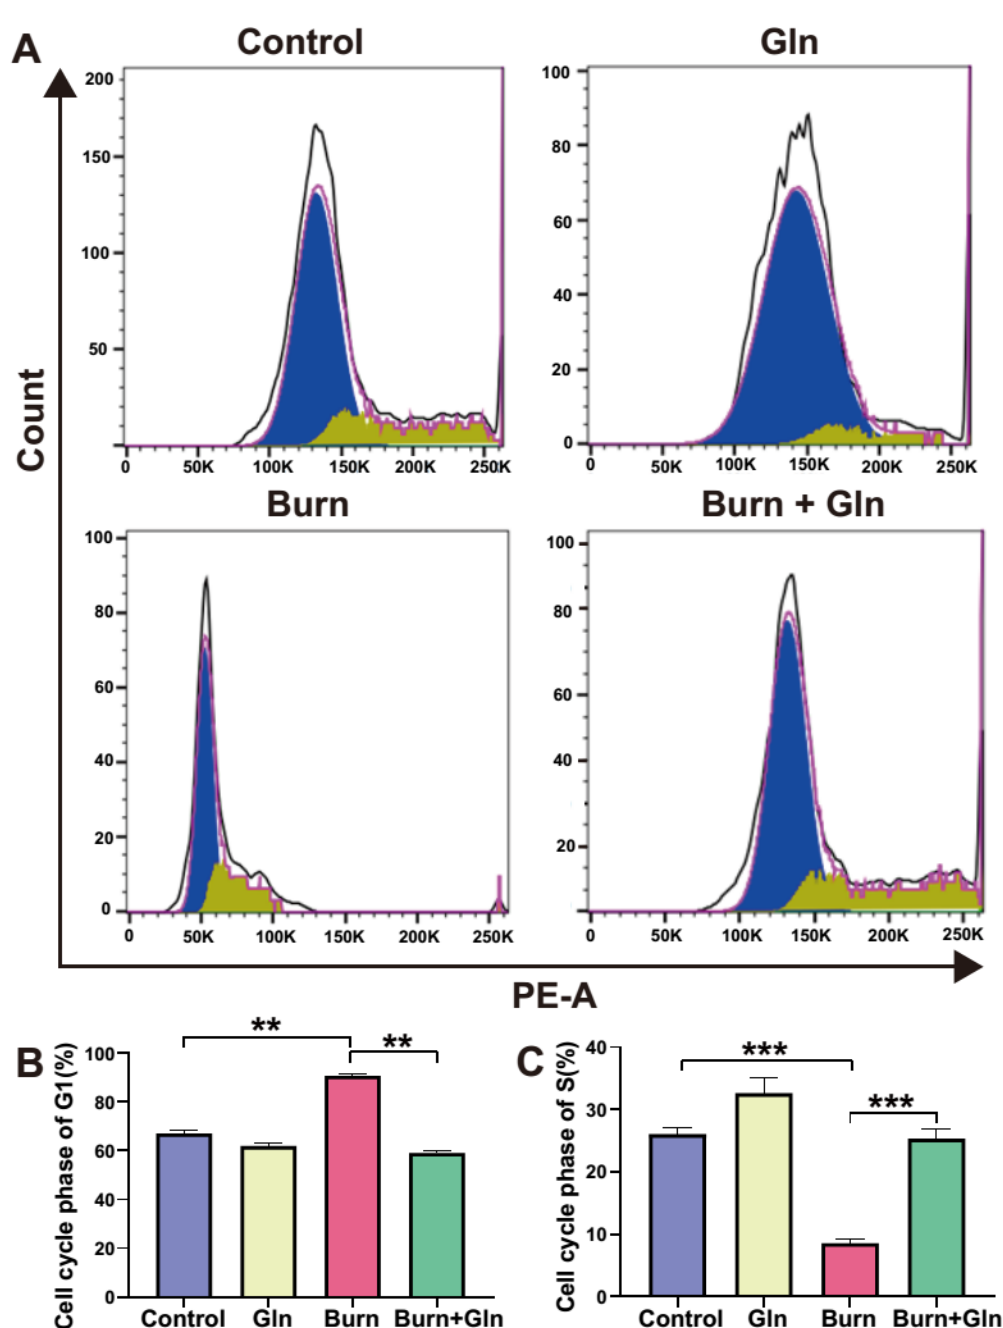
Figure 6. Gln could promote proliferation and accelerate cell cycle. ( A ) Flow cytometry was used to analyze the typical cell cycle of small intestinal stem cells treated in different groups. ( B ) The proportion of G1 phase of cell cycle in different groups. ( C ) The proportion of S phase of cell cycle in different groups. Data were expressed as mean ± SEM from 6 independent experiments ( n = 6). PE-A represents the curve area of fluorescence intensity. The blue part represents the cell cycle phase of G1 and the yellow part represents the cell cycle phase of S. ** p < 0.01, *** p < 0.001 using 1-way ANOVA and post hoc Tukey’s test.